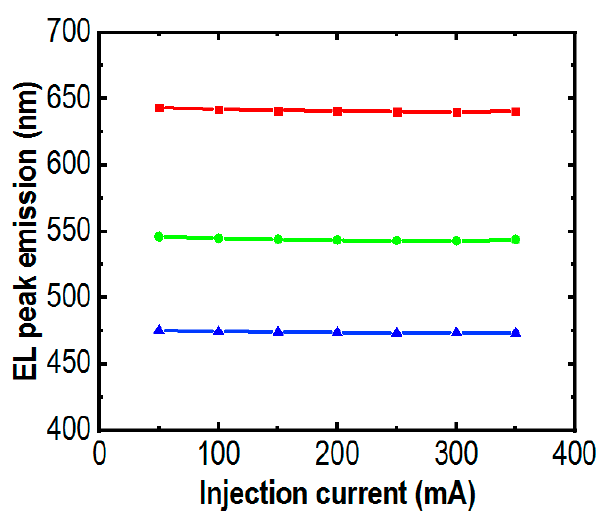
Figure 5. The peak emissions of red, green and blue μ LEDs measured under different injection currents from 50 mA to 350 mA.